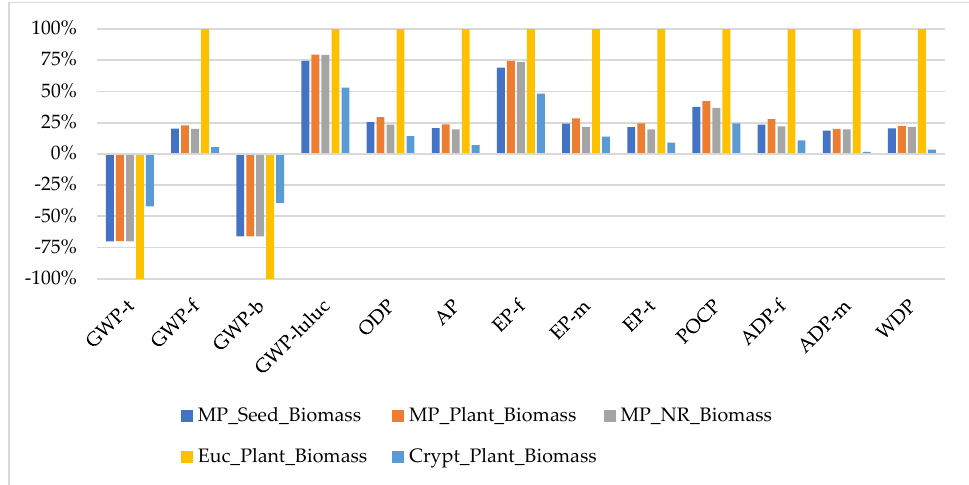
Figure 2. Relative core environmental impacts per cubic meter of biomass.